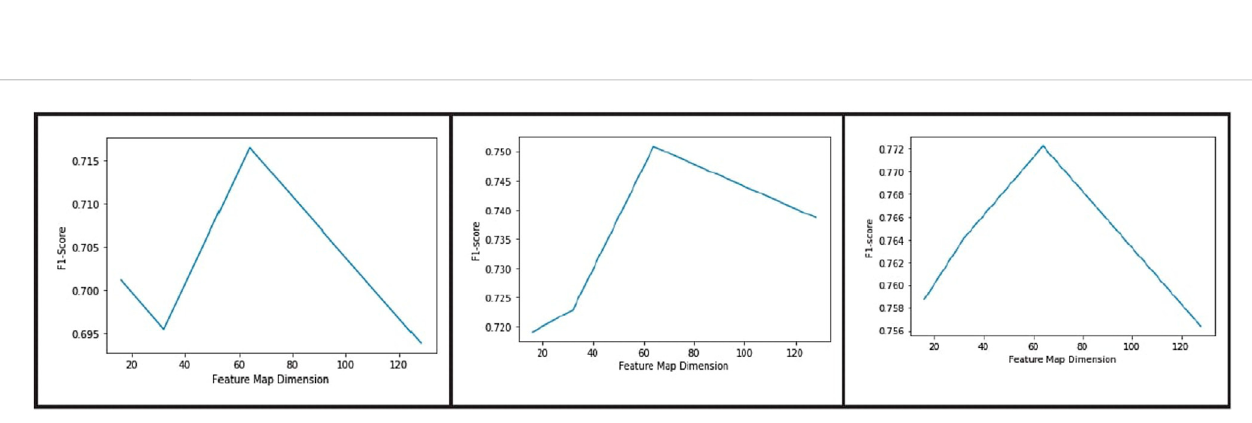
FIGURE 9 Plot of dice score vs dimension of the feature map in the bottleneck layer for blood vessel segmentation from the DRIVE, CHASE_DB, and HRF datasets (from left to right).